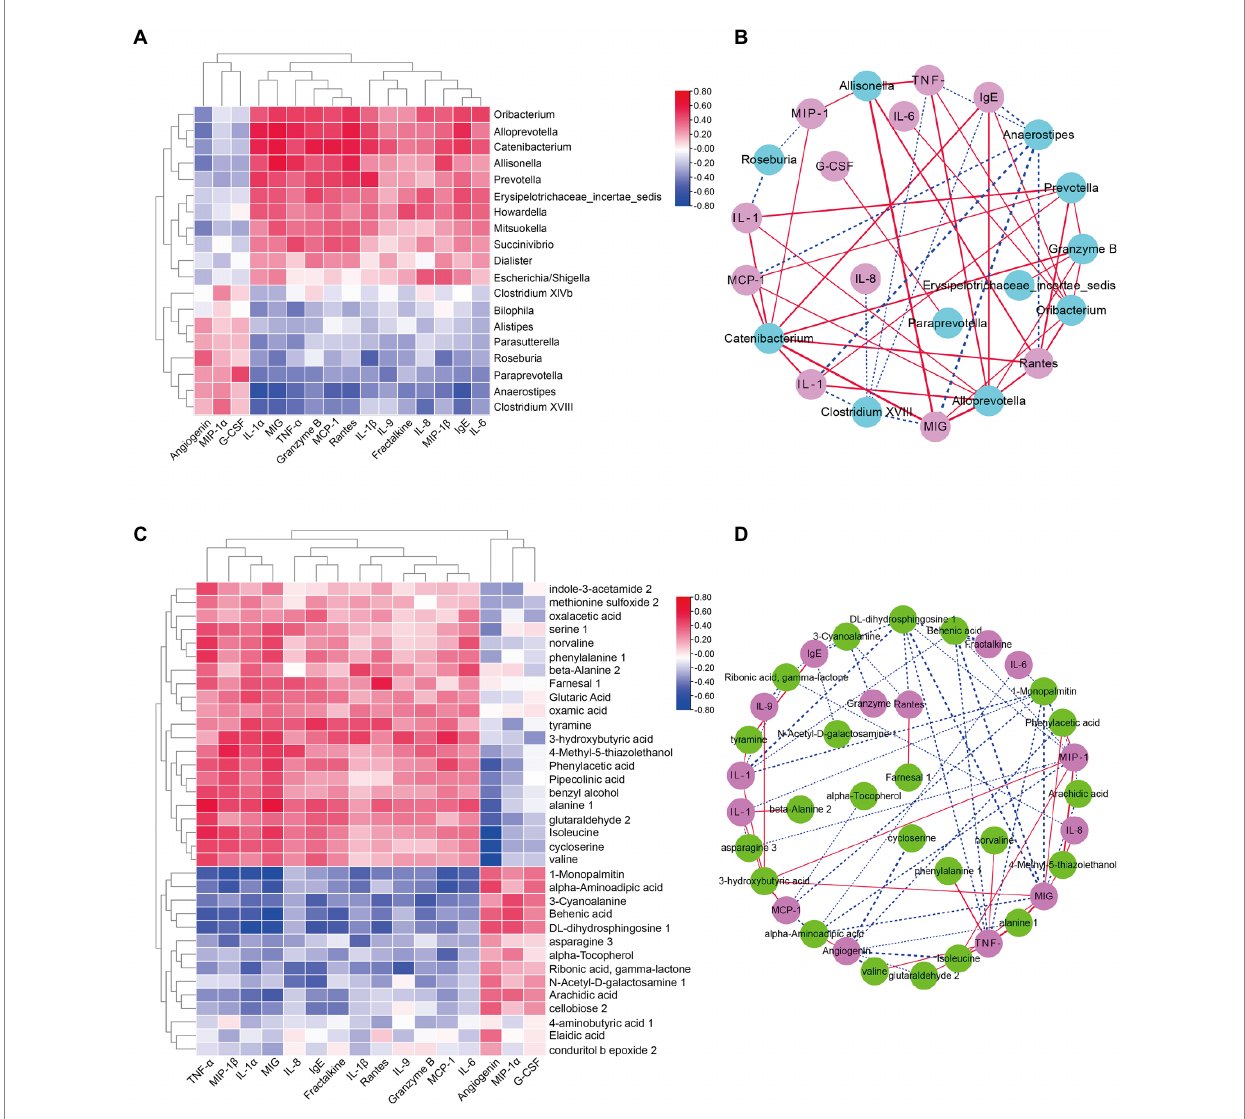
FIGURE 6 Correlation analyses of intestinal bacterial flora, metabolites, and cytokine levels in DS and non-DS groups. (A) Heatmap of Spearman’s correlation between the key intestinal bacterial phylotypes and cytokine levels. Red indicates a positive correlation and blue indicates a negative correlation. (B) Visualization of the correlation network based on partial correlation between the key intestinal bacterial phylotypes (teal) and cytokines (pink). Red lines indicate a positive correlation and blue lines indicate a negative correlation. The thicker the line, the stronger the correlation. (C) Heatmap of Spearman’s correlation between the significantly different metabolites and cytokine levels. Red indicates a positive correlation and blue indicates a negative correlation. (D) Visualization of the correlation network based on partial correlation between the significantly different metabolites (green) and cytokines (purple). Red lines indicate a positive correlation and blue lines indicate a negative correlation. The thicker the line, the stronger the correlation. HC, non-DS volunteers (or non-DS group); DS, individuals with DS (or DS